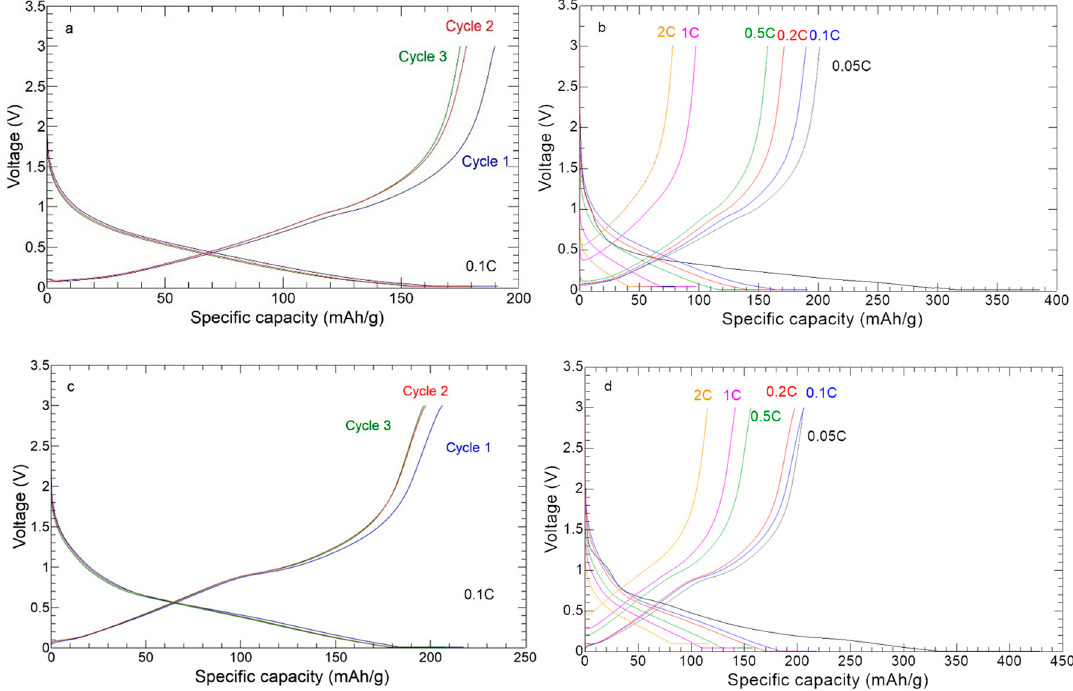
Figure 12. Charge/discharge curves: ( a ) three cycles at 0.1 C of 10%ZnS–GO/CNF; ( b ) one cycle at each C-rate of 10%ZnS–GO/CNF; ( c ) three cycles at 0.1 C of 30%ZnS–GO/CNF; ( d ) one cycle at each C-rate of 30%ZnS–GO/CNF.